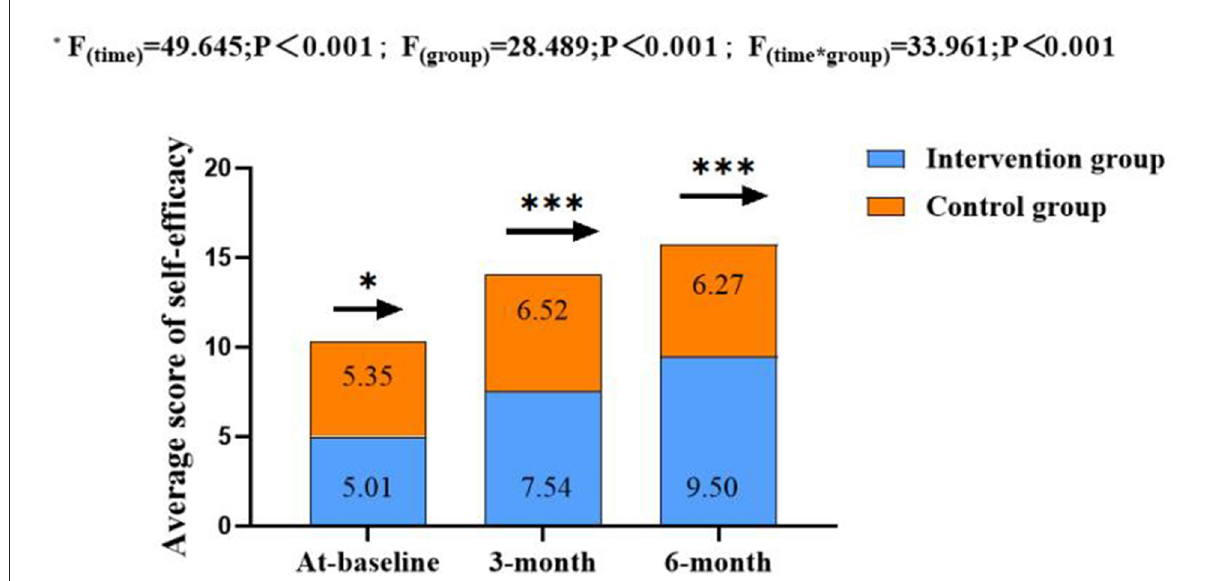
FIGURE3 Total score changes in self-efficacy at baseline, third, and sixth month post-intervention among the PCOS patients. * p > 0.05, ** p < 0.01, *** p < 0.001; *Repeated measurement analysis of variance.